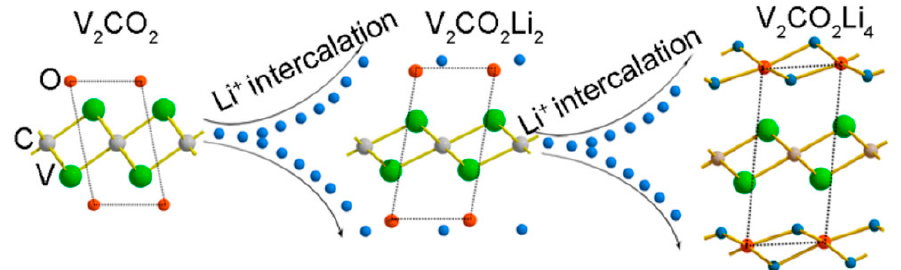
Figure 1. Schematic representation of the lithiation process in V-type (V 2 CO 2 , Cr 2 CO 2 , and Ta 2 CO 2 ) MXenes. Reprinted with permission from [36]. Copyright © 2016, American Chemical Society.